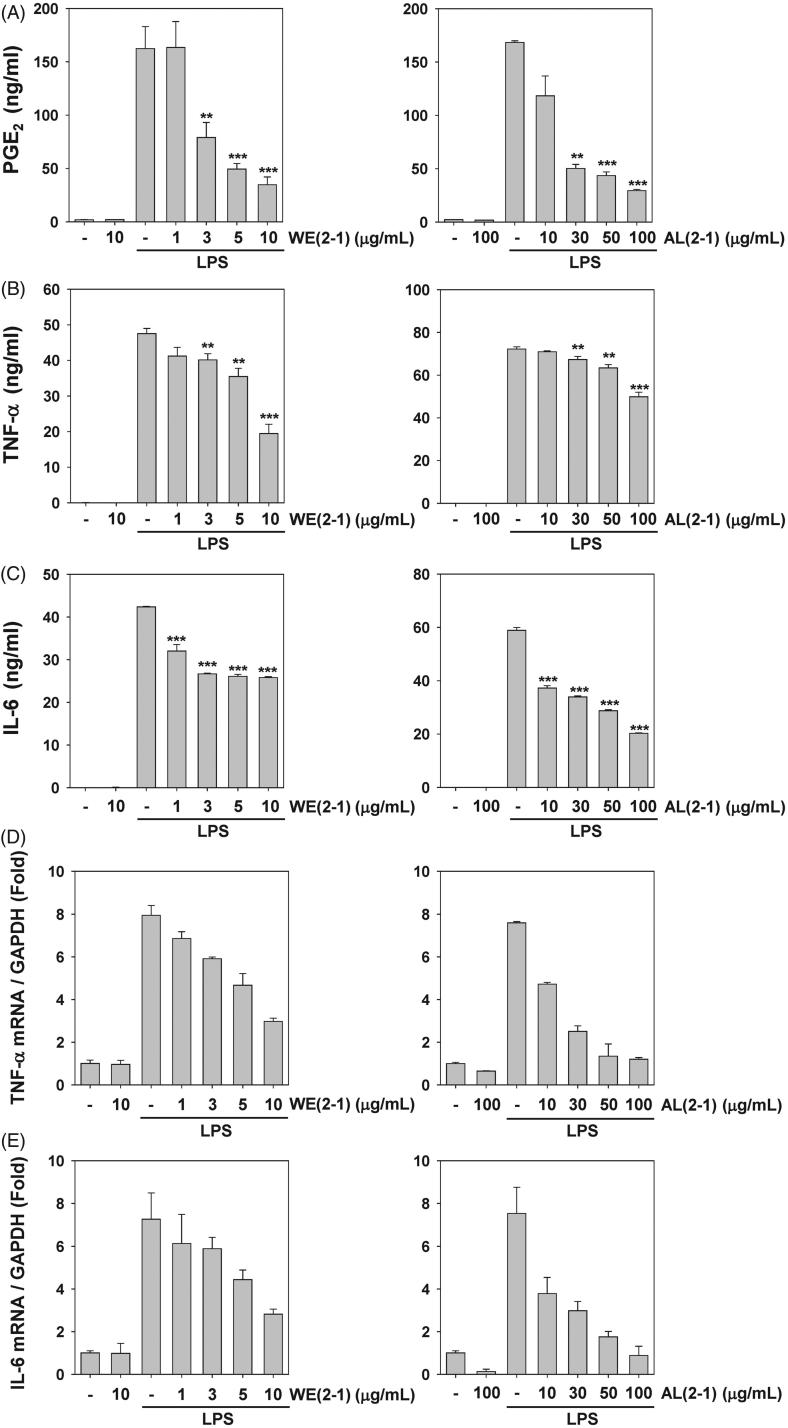
Inhibition of LPS-induced several inflammatory biomarkers by WE(2-1) and AL(2-1) in RAW 264.7 macrophages. (A) Cells were pre-treated with different concentrations of WE(2-1) and AL(2-1) for 2 h and stimulated with LPS (1 µg/mL final concentration) for 22 h. The amount of PGE2 release was determined by the mouse PGE2 ELISA kit. Data were obtained from three independent experiments and were expressed as means ± SD. **p < 0.01 and ***p < 0.001 indicate significant differences from the LPS-treated group. (B) Cells were pre-treated with different concentrations of WE(2-1) and AL(2-1) for 2 h and stimulated with LPS (1 µg/mL final concentration) for 22 h. The amount of TNF-α release was determined by a TNF-α antibody-coated enzyme-linked immunosorbent assay (ELISA) kit following the manufacturer’s instructions. Data were obtained from three independent experiments and were expressed as means ± SD. **p < 0.01 and ***p < 0.001 indicate significant differences from the LPS-treated group. (C) Cells were pre-treated with different concentrations of WE(2-1) and AL(2-1) for 2 h and stimulated with LPS (1 µg/mL final concentration) for 22 h. The amount of IL-6 release was determined by an IL-6 antibody coated ELISA kit following the manufacturer’s instructions. Data were obtained from three independent experiments and were expressed as means ± SD. **p < 0.01 and ***p < 0.001 indicate significant differences from the LPS-treated group. (D and E) Cells were pre-treated with different concentrations of WE(2-1) and AL(2-1) for 2 h and stimulated with LPS (1 µg/mL final concentration) for 22 h. The total RNA was isolated, and examined via Real-time PCR for the TNF-α and IL-6 genes. Glyceraldehyde-3-phosphate dehydrogenase (GAPDH) was employed as an internal control to demonstrate equal RNA loading.